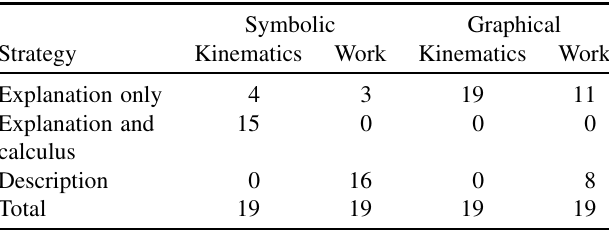
TABLE IX. Comparison of strategies when handling tasks across the two topics requiring a qualitative